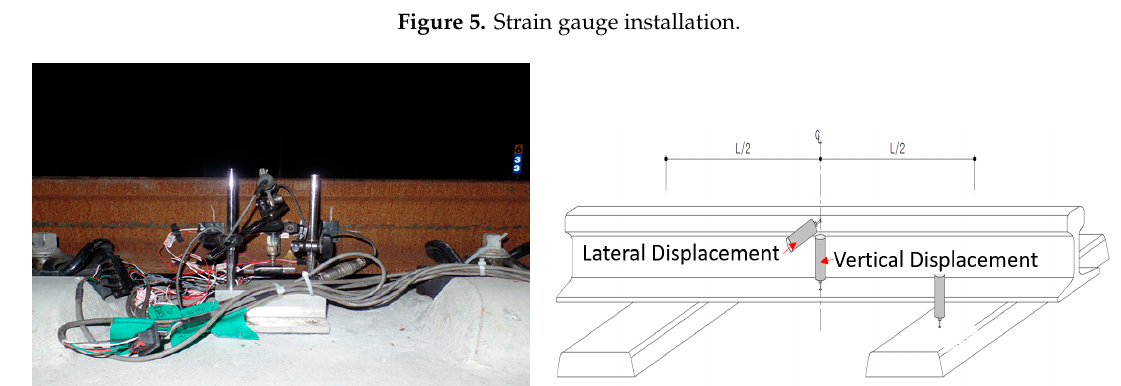
Figure 6. LVDT installation image.